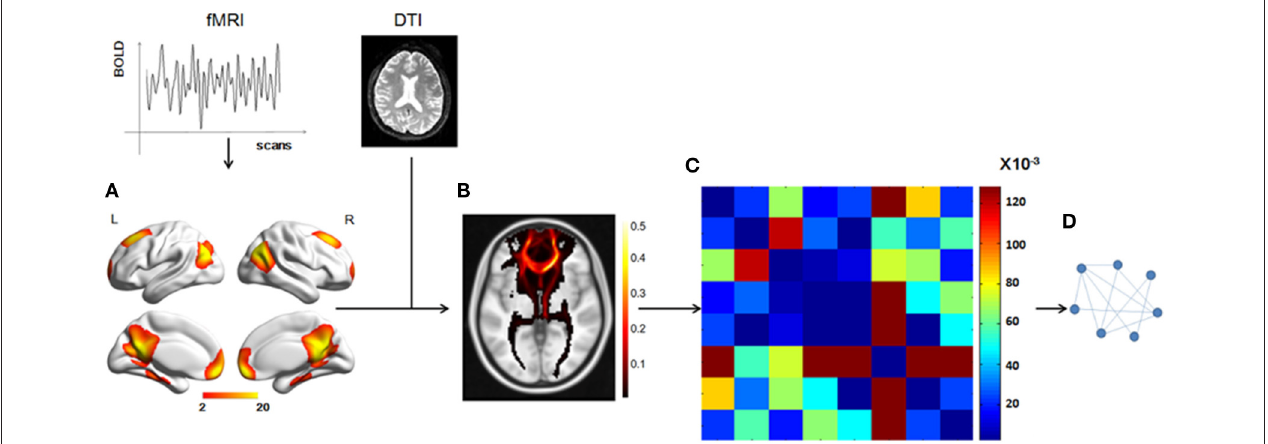
FIGURE 1 | Total workflow before the statistical analysis. (A) The DMN mask was extracted from fMRI data using group ICA, with a threshold of z = 2 . (B) A probabilistic fiber tractography method was used to track the fibers from each ROI and the connectivity probability between any two ROIs was calculated to get the matrix (C) . (D) A graph theory method, in which the nodes represented the ROIs and the weighted edges reflected the connectivity probabilities between any two nodes, was used to analyze the DMN structural network.